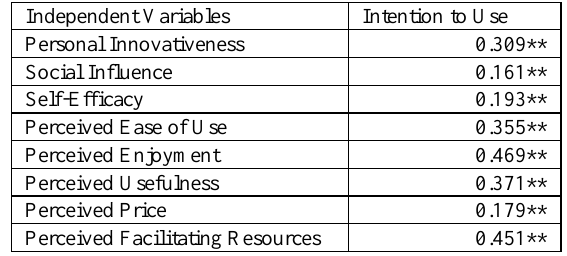
Table 1. Pearson Correlation